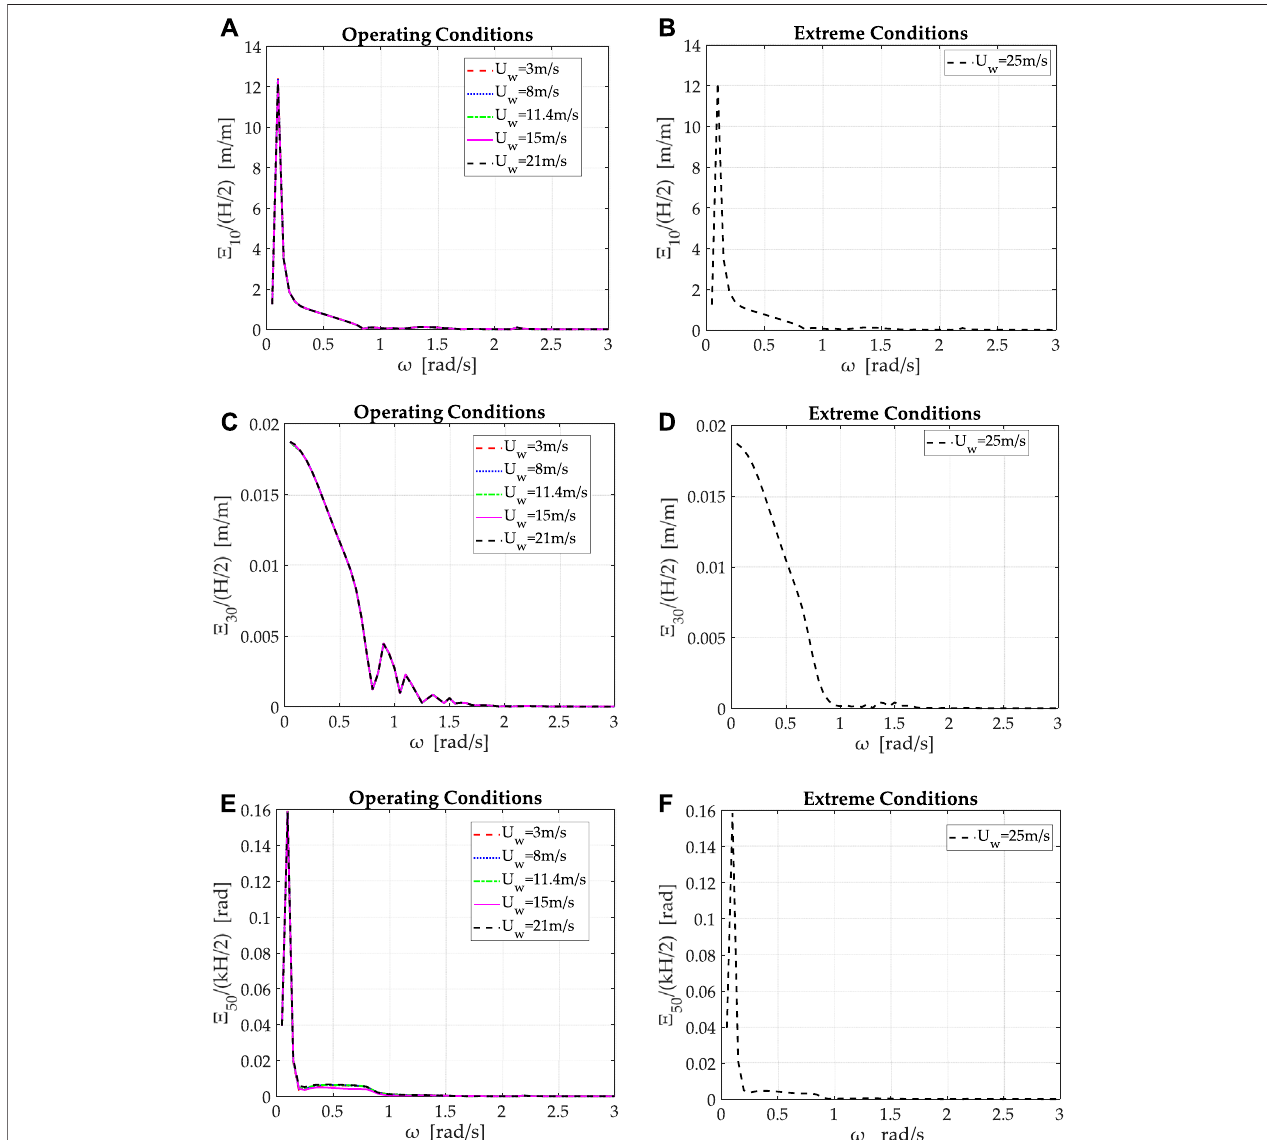
FIGURE 9 | Non-dimensional translational and rotational motions of the hybrid structure at the North Sea installation location for operating and extreme environmental conditions: (A) , (B) Ξ 10 / ( H